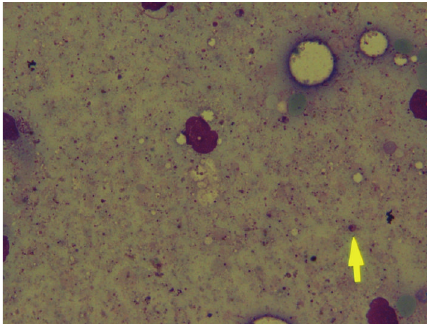
Figure 3: Bone marrow smear revealed a few Leishman bodies, one of them showed by arrowhead (Wright’s stain